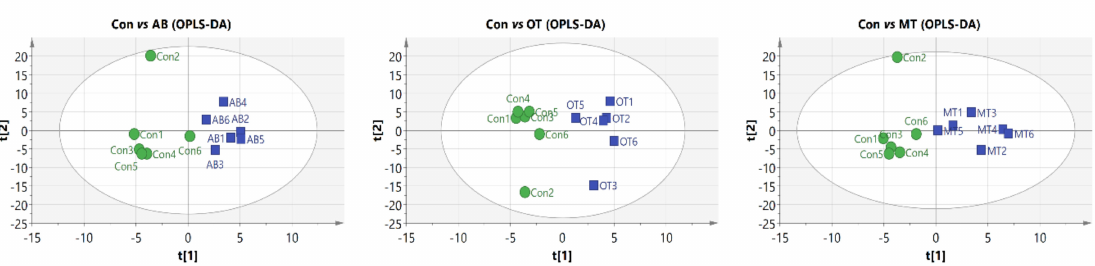
Figure 4. Gas chromatography time-of-flight mass spectrometry (GC-TOF-MS) and metabolomics analysis. Orthogonal projections to latent structures-discriminant analysis (OPLS-DA) score map derived from the GC / MS metabolite profiles of intestinal contents ( n =